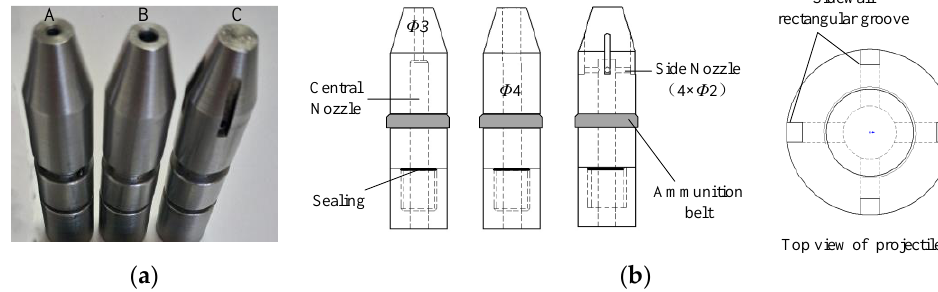
Figure 2. The gas-curtain projectiles. ( a ) Physical picture, ( b ) schematic diagram of projectile structure. Table 1. Structure and dimension of gas-curtain projectiles.